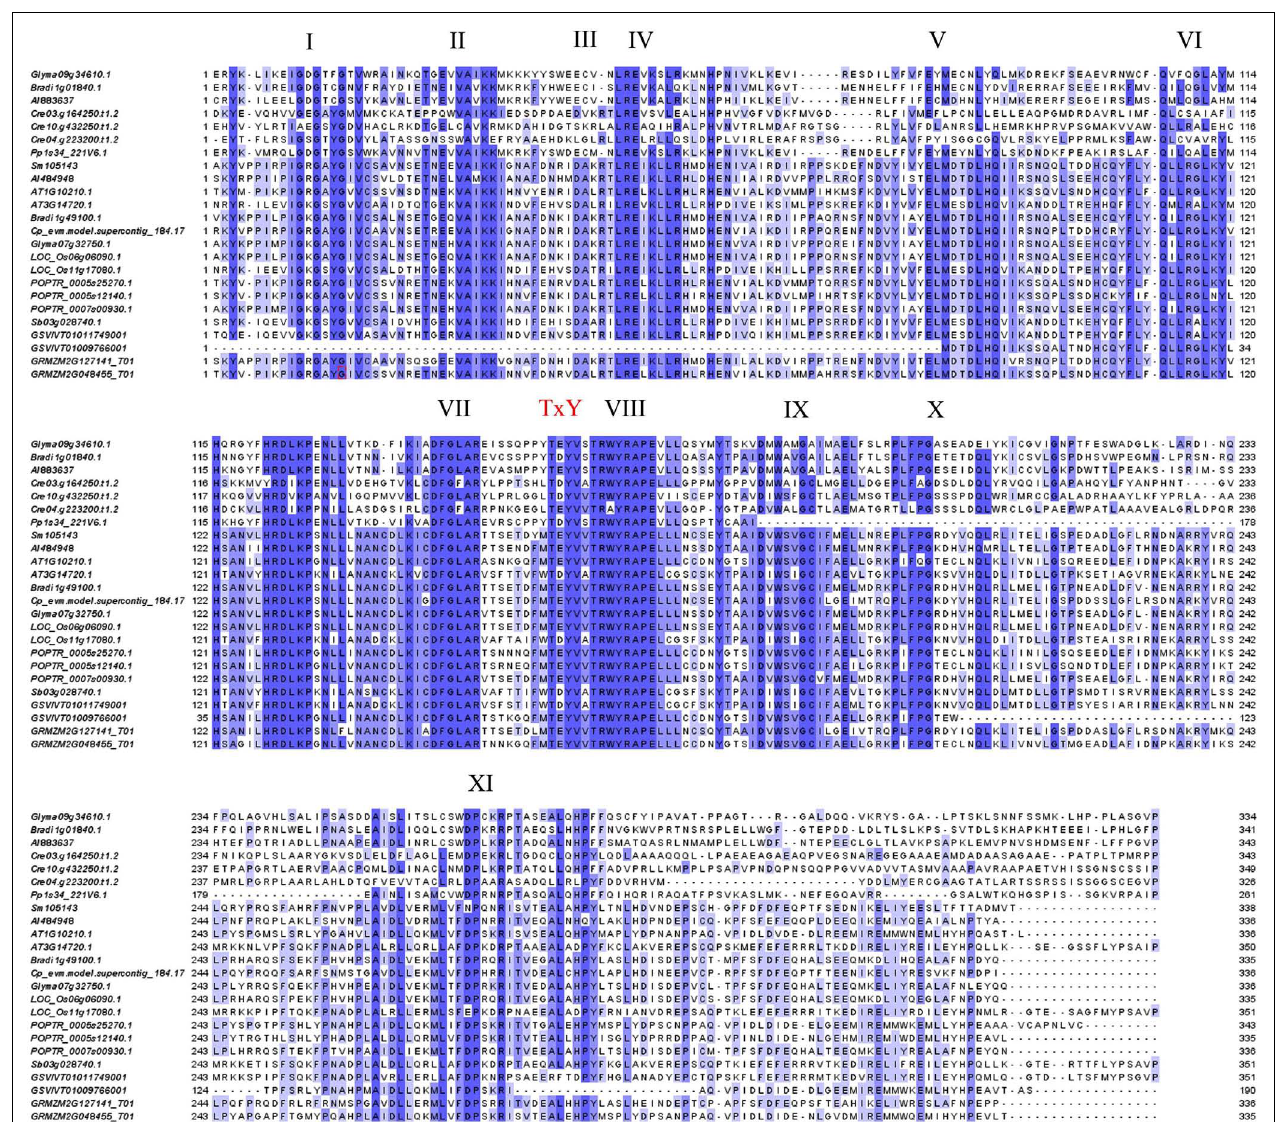
illustrated in Jalview (Waterhouse et al., 2009). Conserved kinase domains and theTxY activation loop are indicated. Blue color represents percent sequence